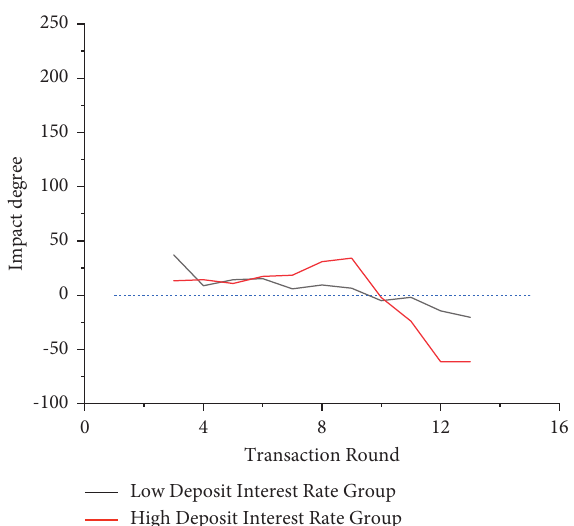
Figure 3: The effect of the two deposit interest rate groups on regulating housing